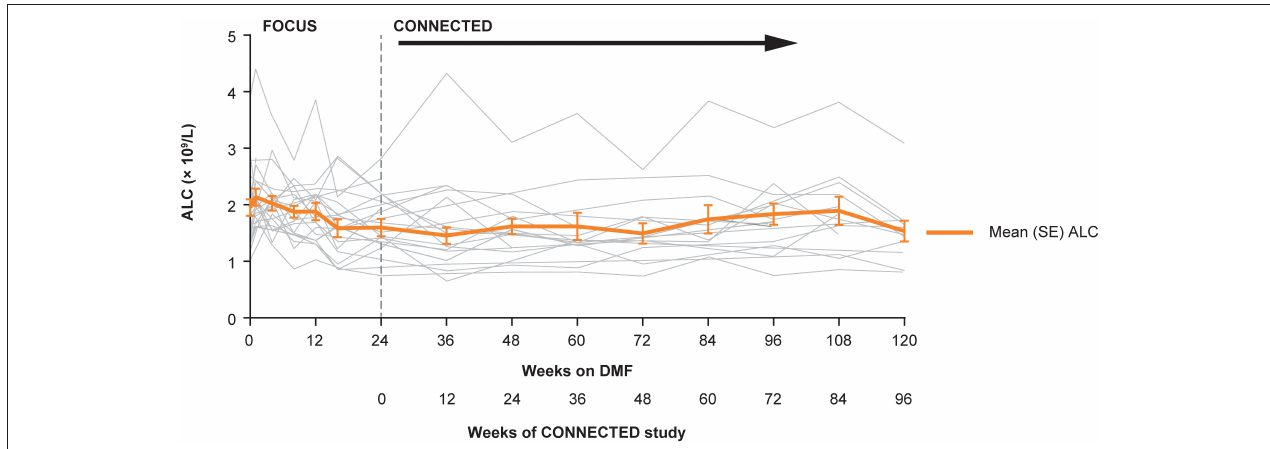
FIGURE 2 | Individual and mean (SE) ALCs over time in the FOCUS and CONNECTED studies. ALC, absolute lymphocyte count; DMF, delayed-release dimethyl fumarate; SE, standard error.